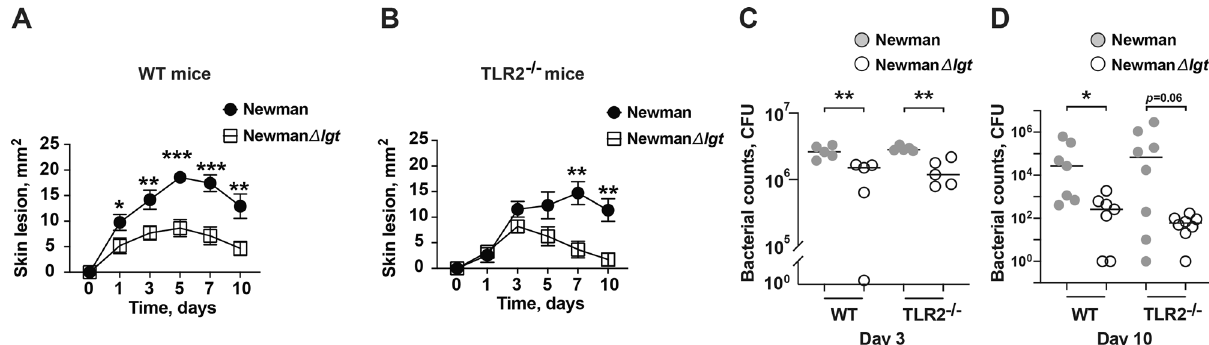
Fig. 4 S. aureus Lpp-induced fulminant bacterial growth is independent of host TLR2 signaling. The skin lesion size (mm 2 ) in C57BL/6 wild-type (WT) mice ( A ) and TLR2 de fi cient (TLR2 − / − ) mice ( B ) up to 10 days after subcutaneous (s.c.) skin injection with 20 μ l of Staphylococcus aureus Newman parental strain or Newman Δ lgt mutant strain (1.5 – 2.0 × 10 6 colony-forming units [CFU]/site; n = 13 – 14/group). Bacterial counts in the supernatant of skin biopsy homogenates on day 3 ( n = 5/group) ( C ) and day 10 ( n = 7 – 8/group) ( D ) after s.c. skin infection with Newman parental strain or Newman Δ lgt mutant strain (1.5 – 2.0 × 10 6 CFU/site). The data were pooled from two independent experiments. Statistical evaluations were performed using the Mann – Whitney U test, with data expressed as the mean ± standard error of the mean ( A , B ), or presented as scatterplot with line indicating median value ( C , D ). * P < 0.05; ** P < 0.01; *** P <